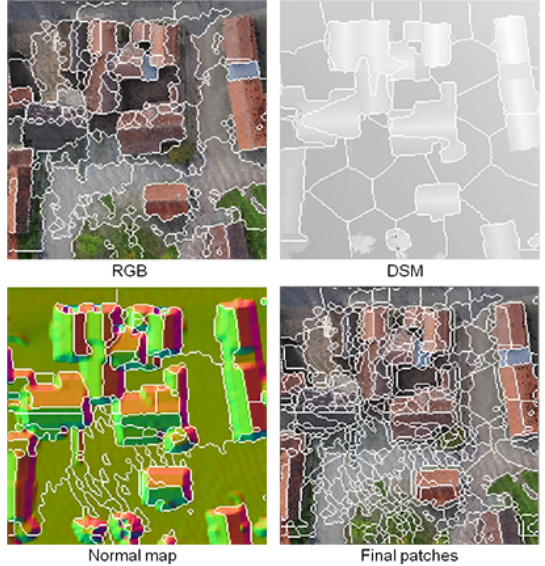
Figure 8. Relative feature of both color and